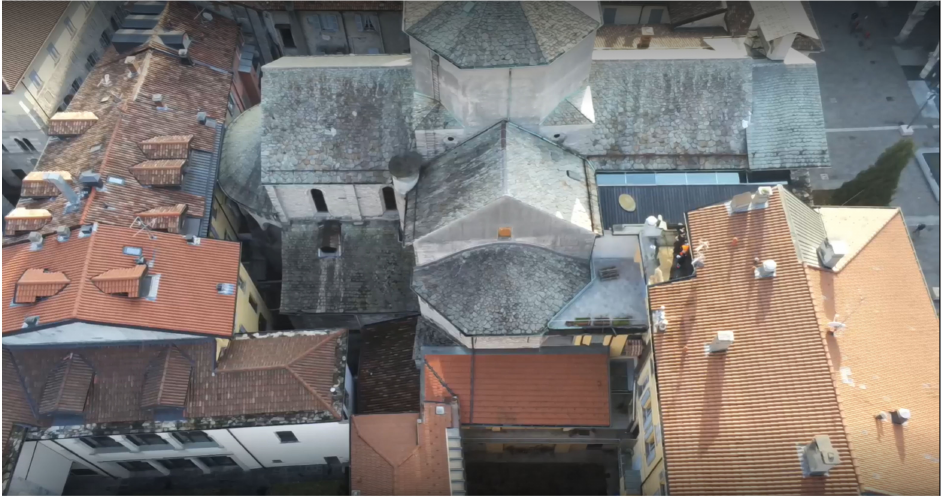
Figure 6. Drone acquisition captured by the Politecnico di Milano team directed by Marco